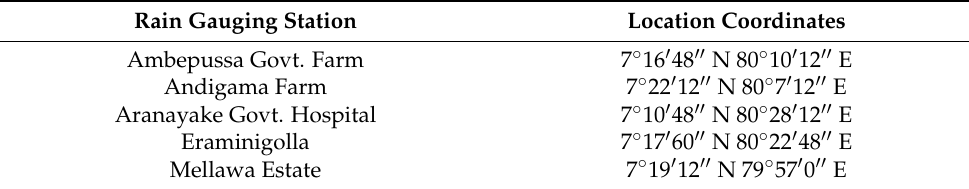
Table 1. Location of rain gauging stations in Maha Oya River Basin.